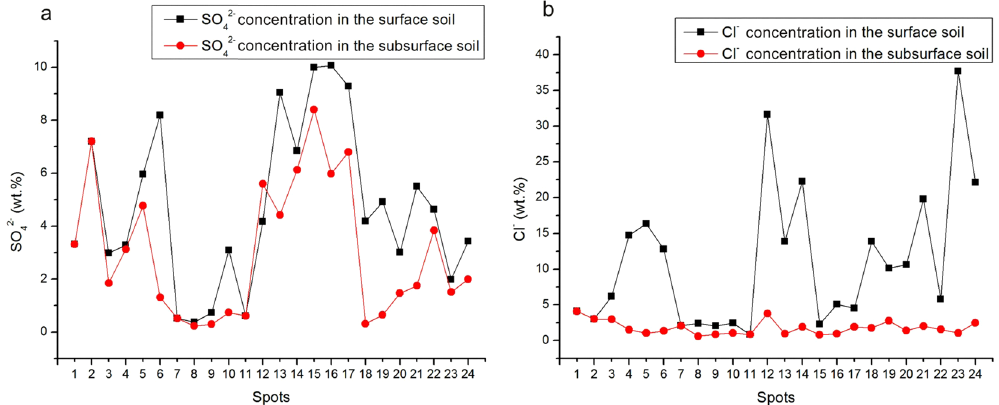
Figure 4. The distributions of the main soil anions. ( a ) SO 42 − concentration; ( b ) Cl − concentration.